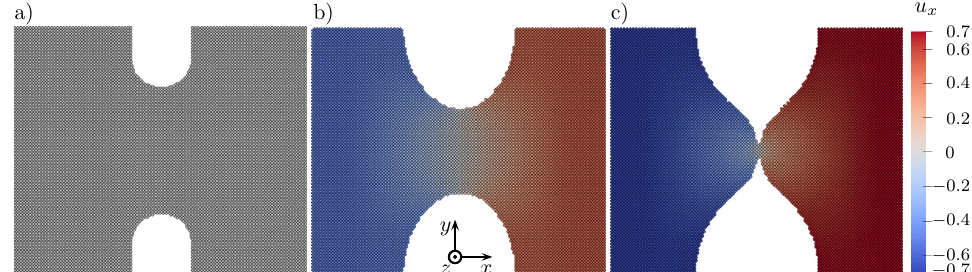
Figure 2. Discrete atom displacement field. The images show the displacement component u x along the x-axis at ( a ) the initial state, ( b ) an intermediate state and ( c ) the final state.